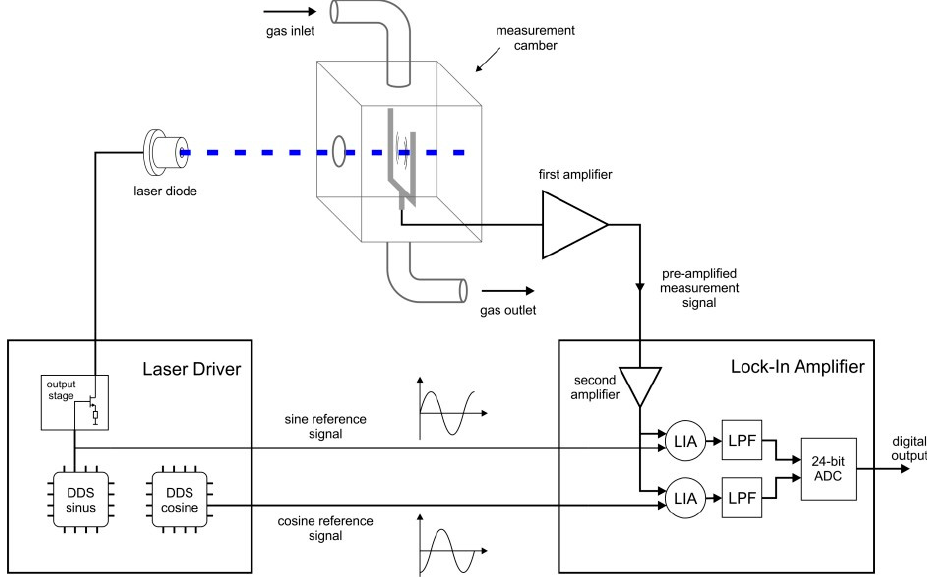
Figure 1. Functional principle of measurement setup, outline of the circuitry components and